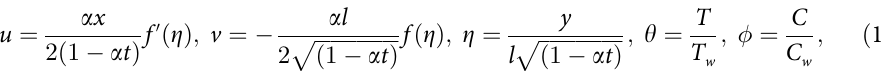
ffiffiffiffiffiffiffiffiffiffiffiffiffiffiffiffi p f Z ð Þ ; Z ¼ ð 1 (cid:0) a t Þ